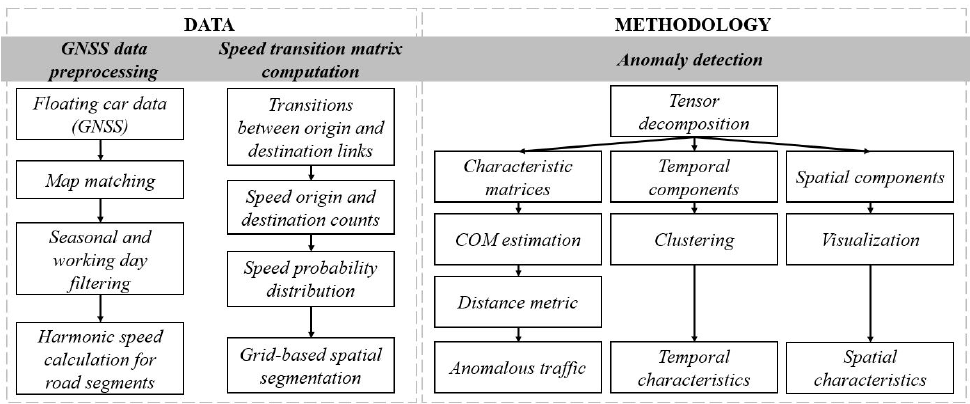
Figure 3. Proposed methodology for the anomaly